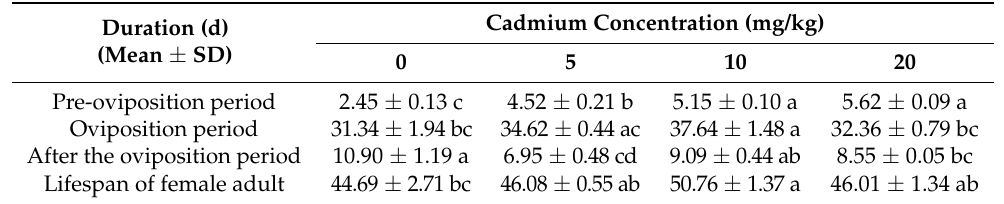
Table 1. Effects of different cadmium concentrations on the oviposition duration of Aleuroglyphus ovatus . Different lowercase letters indicate significant differences among control and treatment groups at different cadmium concentrations ( p < 0.05).